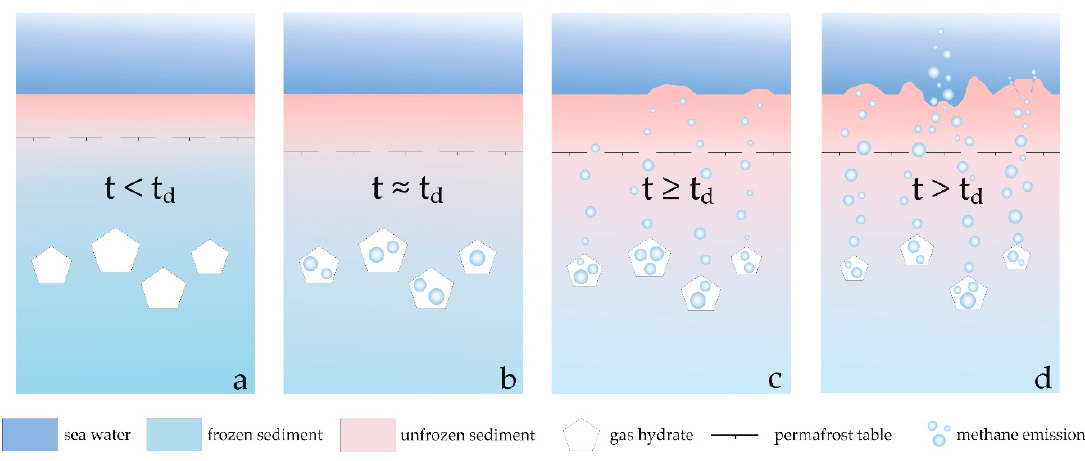
Figure 6. Evolution of hydrate-bearing subsea permafrost exposed to progressive temperature increase ( a , b , c , d - details below in text).